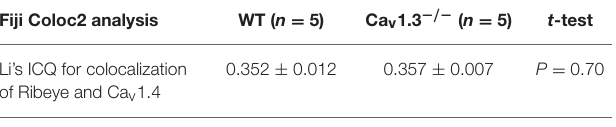
Image J analysis of fluorescent positive structures at the OPL Ribeye positive